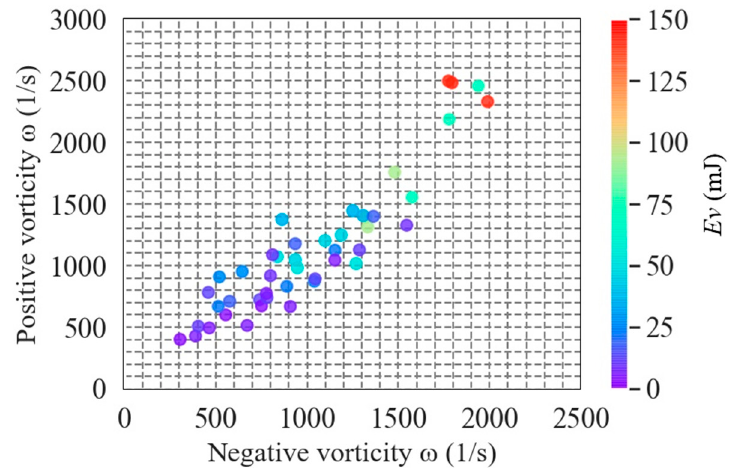
Figure 12. Comparison of positive and negative vorticities.